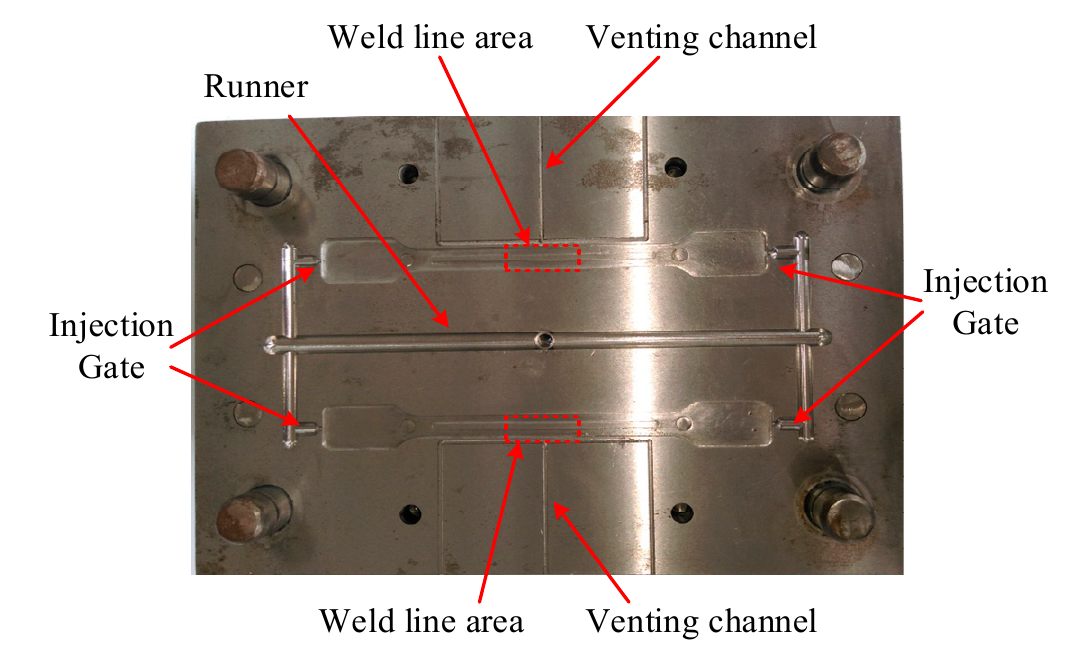
Figure 3. The cavity plate for molding the testing part.